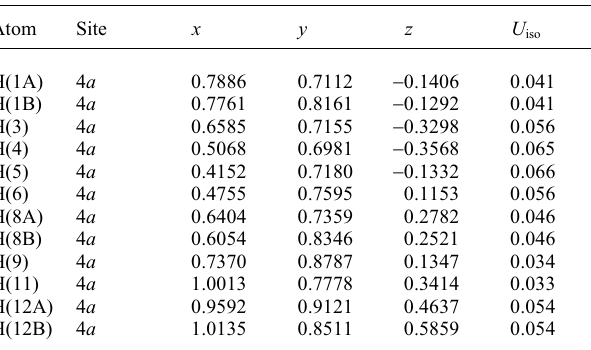
Table 2. Atomic coordinates and displacement parameters (in Å 2 )